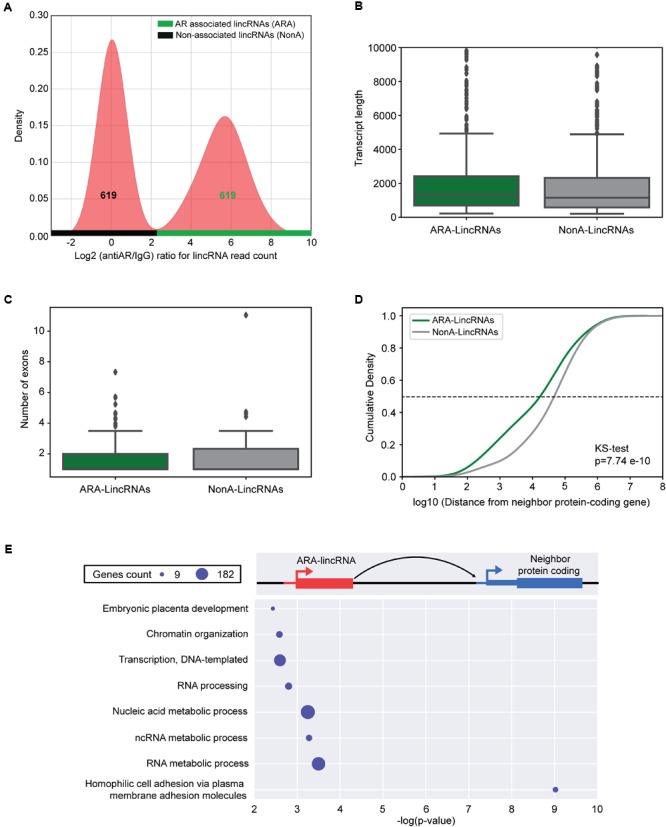
lincRNAs are associated to the androgen receptor in LNCaP cells. (A) Density distribution of log2 ratio (antiAR/IgG) for the lincRNAs read counts detected in the RIP-seq assay with antiAR antibody (antiAR) or with control non-immune serum (IgG). RIP-seq assay was performed in duplicate in LNCaP cells treated for 6 h with 0.1 nM androgen. The curve on the right (over the horizontal green bar) shows the distribution of 619 lincRNAs that were significantly enriched (FDR < 10%, DESeq2) in the anti-androgen receptor (antiAR) fraction in relation to the control fraction (non-specific IgG), which are the androgen-receptor associated lincRNAs (ARA-lincRNAs). The curve on the left (over the horizontal black bar) shows distribution of an equivalent set of 619 lincRNAs with log2 ratio (antiAR/IgG) distributed around zero in the RIP-seq assay, representing lincRNAs non-associated to the androgen receptor (NonA-lincRNAs), which were chosen as a control group. (B) Box plot of the lengths of ARA-lincRNAs (red) and of NonA-lincRNAs (gray). (C) Box plot of the number of exons of ARA-lincRNAs (red) and of NonA-lincRNAs (gray). (D) Cumulative distribution of the distance in bases between the lincRNA of the indicated group (ARA-lincRNAs, green or NonA-lincRNAs gray) and the nearest neighbor protein coding genes in the genome (KS, Kolmogorov–Smirnov test; p-value = 7.74 × 10-10). (E) Protein-coding genes (blue) neighbor to the 619 ARA-lincRNAs belong to the indicated significantly enriched biological process GO terms. The x-axis shows the enrichment significance [-log10 (p-value), hypergeometric statistical test]; all GO terms have a corrected p-value < 0.05 for the enrichment significance. The sizes of the blue circles are proportional to the number of protein-coding genes in each enriched term, as indicated in the scale on the upper left corner.